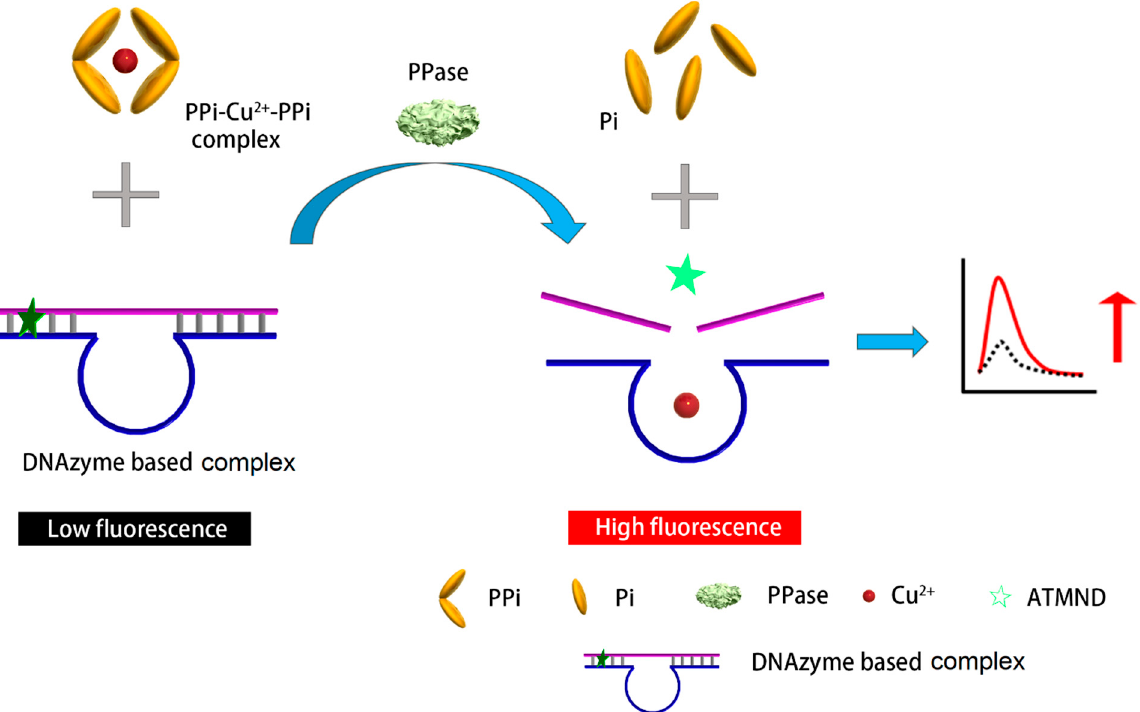
Scheme 1. Schematic representation of the designed substrate/DNAzyme-based biosensor for the fluorescent detection of PPase.